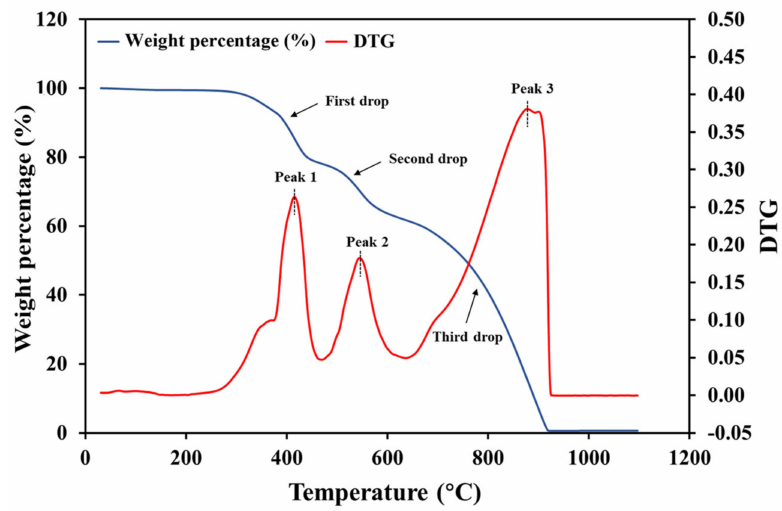
Figure 3. Thermogravimetric curves of CF/EP prepreg heated from room temperature to 1100 ◦ C in air.